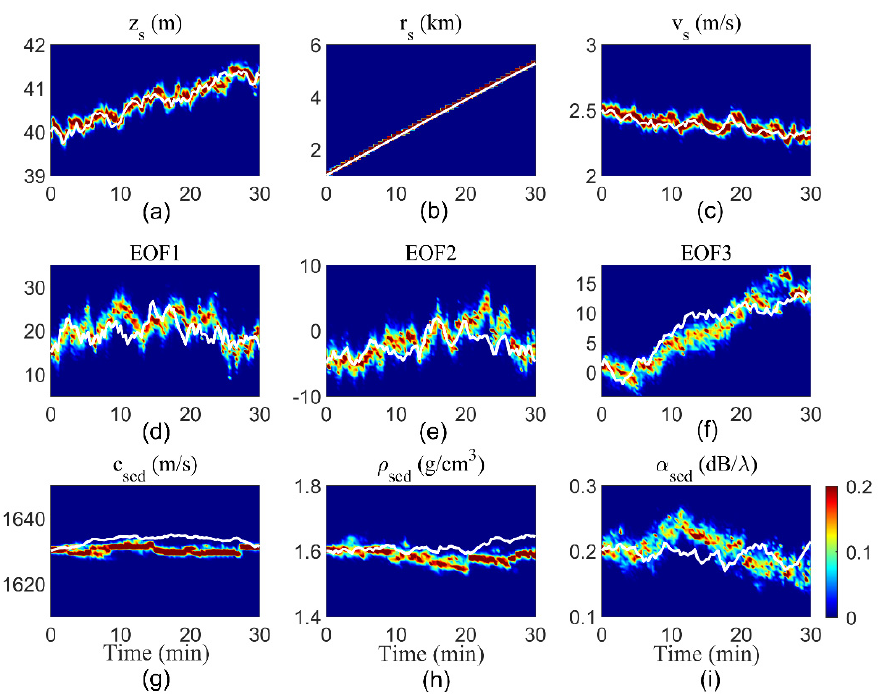
Figure 2. PF tracking results of nine parameters: time-evolving 1-D marginal PPDs for ( a ) depth, ( b ) range, and ( c ) speed of the source; ( d-f ) three EOFs; and sediment ( g ) sound speed, ( h ) density, and ( i ) attenuation. The solid lines represent the true trajectories.